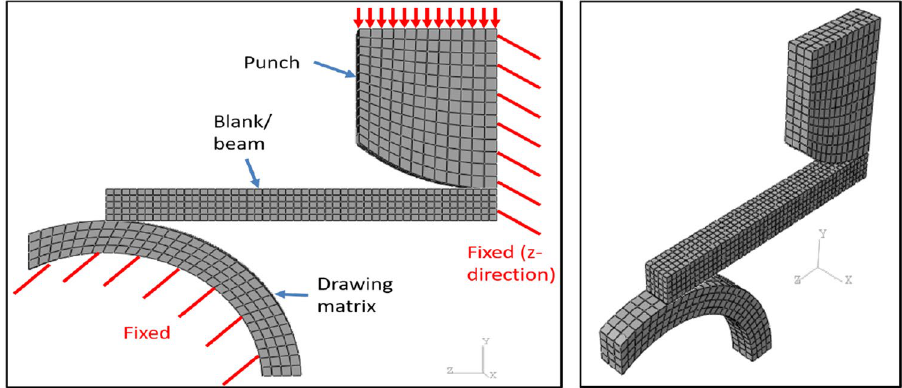
Fig. 18 Deep drawing process in